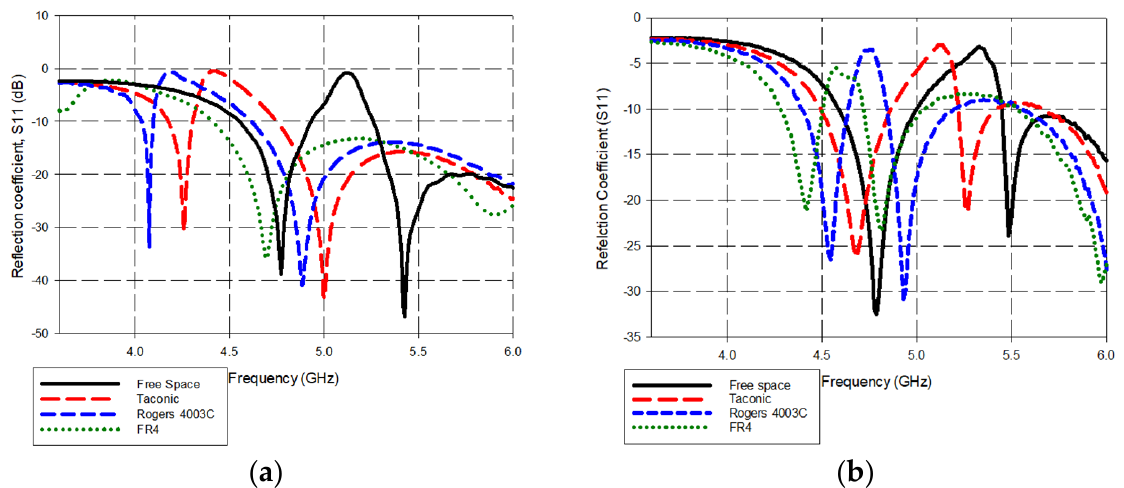
Figure 23. Re fl ection coe ffi cient of the sensing system sensor for di ff erent MUTs: ( a ) Simulated CST; Figure 23. Reflection coefficient of the sensing system sensor for different MUTs: ( a ) Simulated CST; ( b ) measured. ( b )